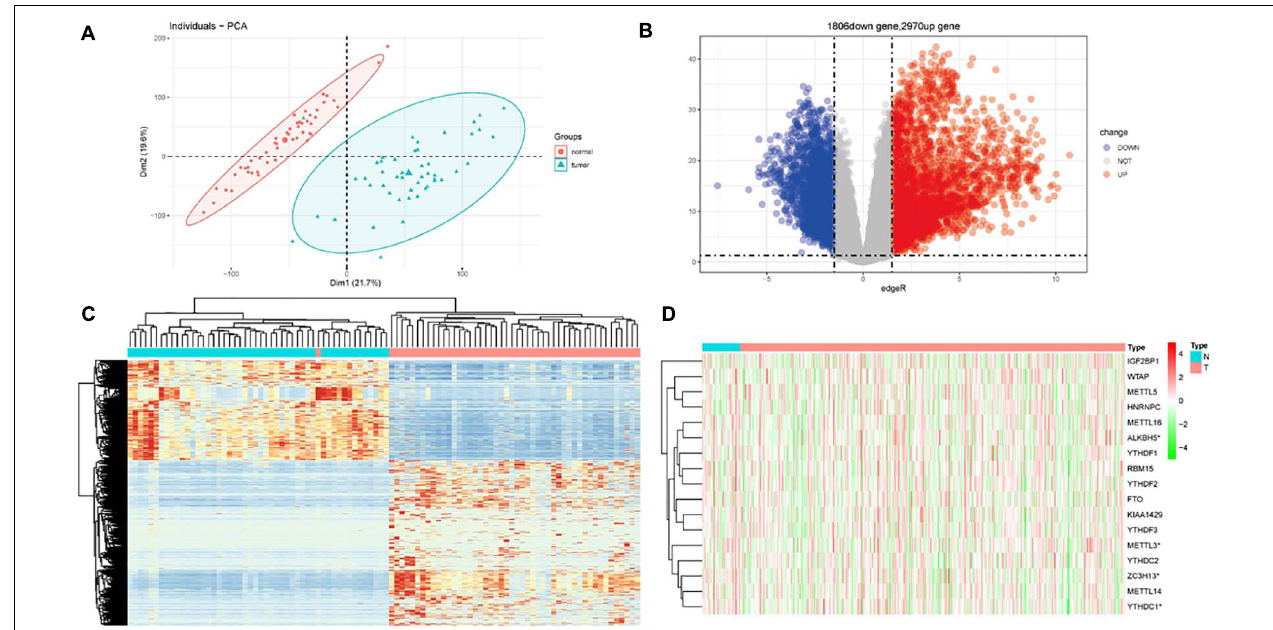
FIGURE 1 | Differentially expressed genes (DEGs) in patients with lung squamous cell carcinoma (LUSC). (A) Principal component analysis (PCA) for tumor and normal tissues. (B) DEGs between tumor and normal tissues. (C) Heat map for DEGs in paired samples. (D) The expression of m6A-related genes in total LUSC patients in TCGA